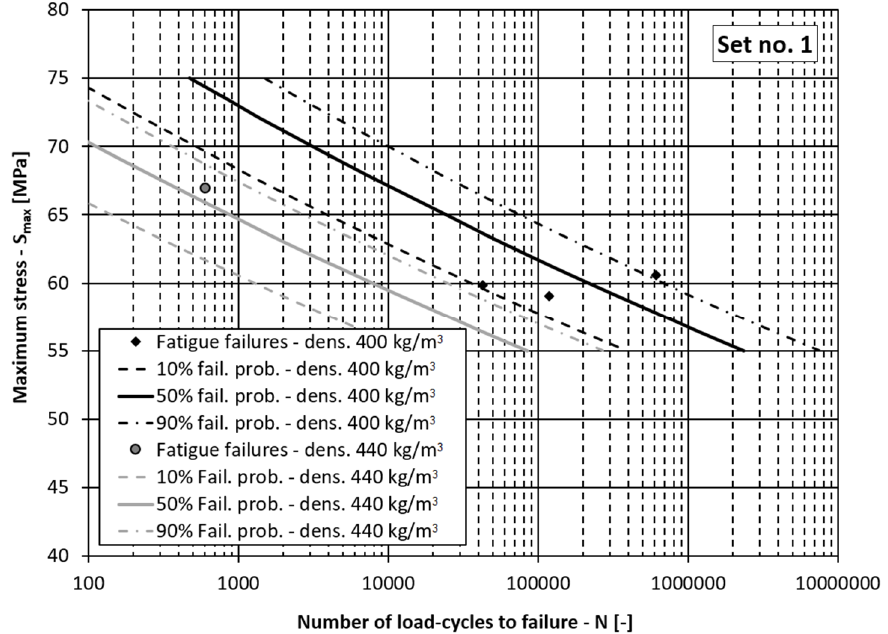
Figure 5. Fatigue-life curves for processing lot 1 and the tangential loading direction. (fail. prob. = failure probability, dens. = wood mass density).